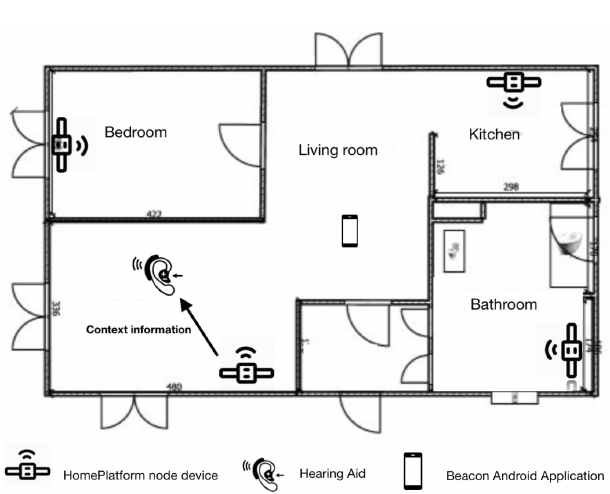
Figure 1. Conceptual diagram showing the home